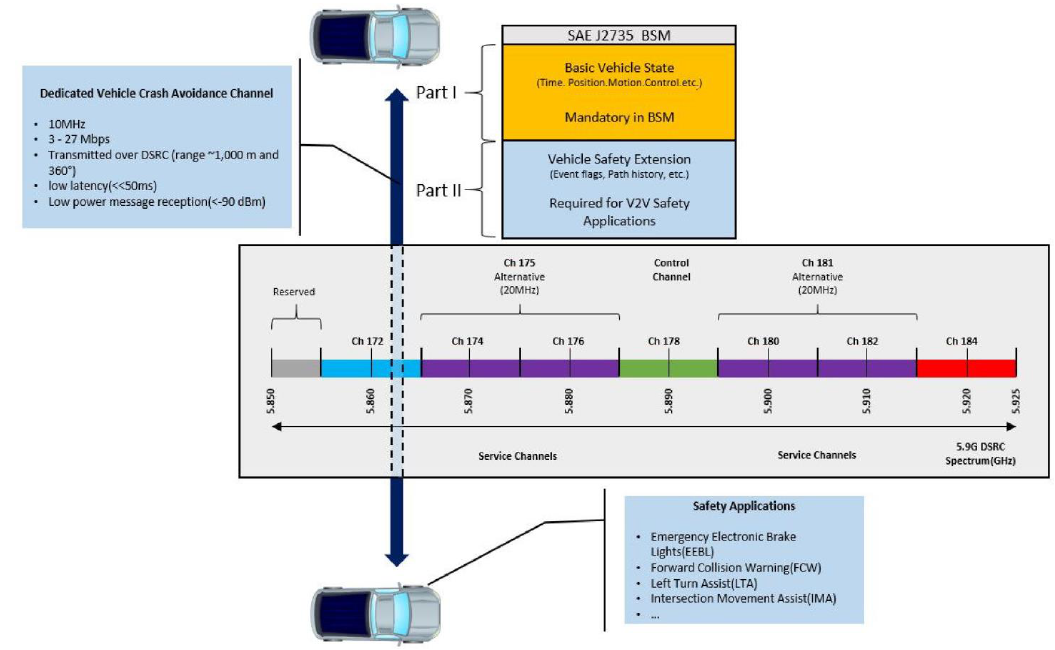
Figure 1. Dedicated Short Range Communication (DSRC) channel band and Basic Safety Messages (BSMs) transmission on channel